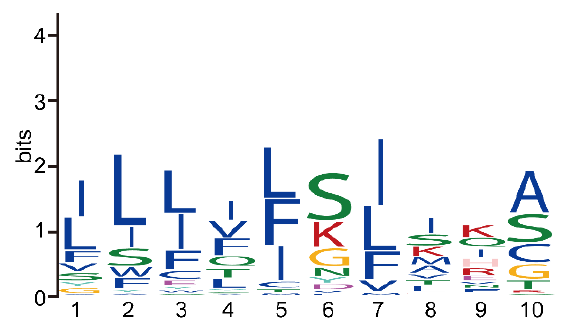
Figure 4. The SP motif of NbRBL family. Conserved motifs of NbRBL SPs analyzed using MEME tools. The conserved amino acid sequence [ILF][LI][LIF][IV][LFI][SK][IL]IK[ASC] in the SP of NbRBL protein, demonstrated that NbRBL proteins had similar secretion pathways.